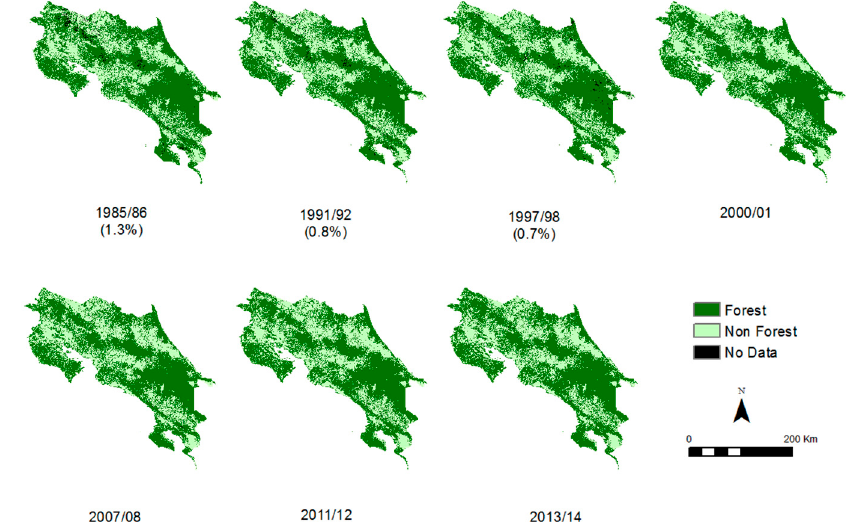
Figure 4. Distribution of the forest and non-forest land cover classes in Costa Rica for every year of the temporal series (1985/1986, 1991/1992, 1997/1998, 2000/2001, 2007/2008, 2011/2012 and 2013/2014). Details about the percent of the country where no class could be assigned due to clouds and shadows are reported in parenthesis. There are not gaps due to cloud and cloud shadows for the years 2000/2001, 2007/2008, 2011/2012 and 2013/2014. For the remainder of the years, gaps without information were filled using land cover information from the Global Forest Change project [39].